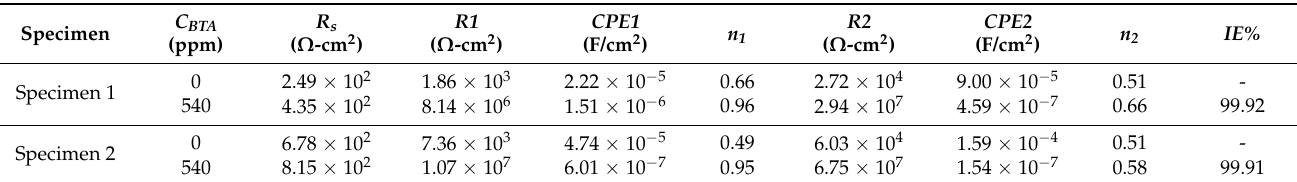
Table 5. Electrochemical parameters from EIS measurements on specimen 1 and specimen 2 in synthetic tap water at 25 ◦ C based on the presence and absence of BTA.